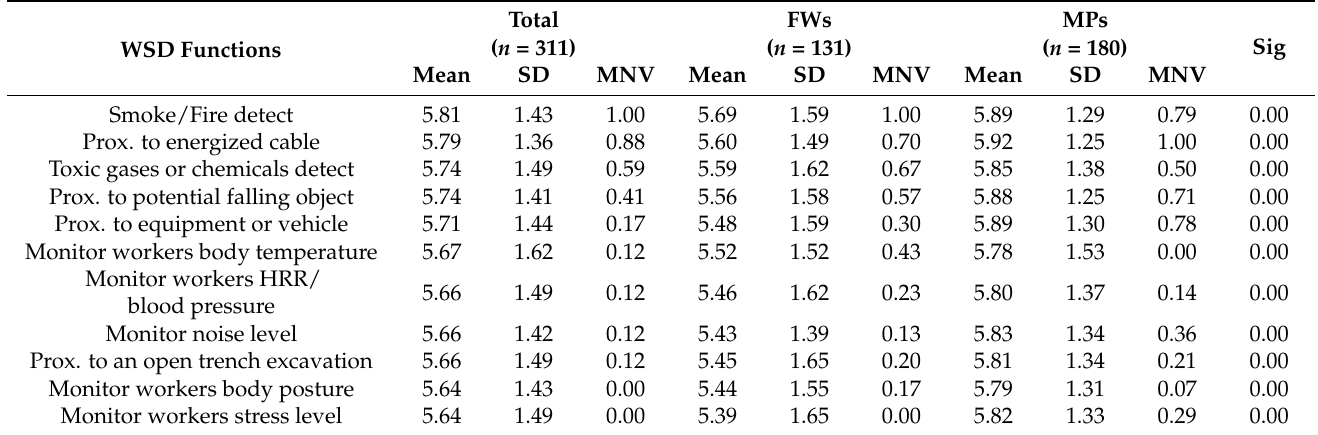
Table 4. Summary of the survey results on the importance of WSD